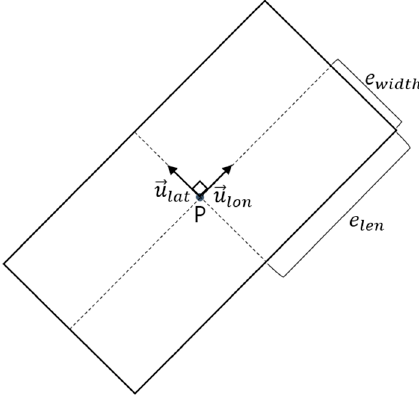
Figure 1. Architecture for a connected and autonomous vehicle (CAV).